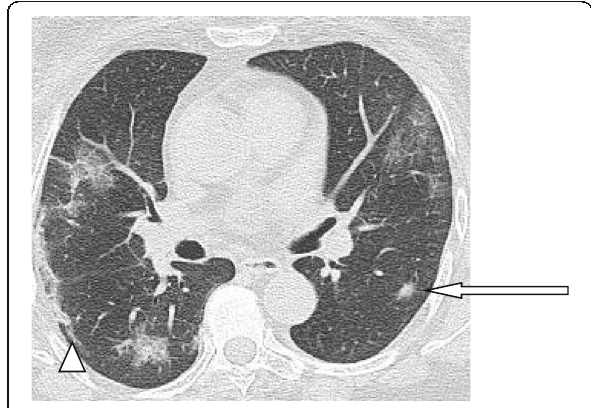
Fig. 11 Patient with COVID-19 pneumonia, with left lower nodule (arrow), note also the presence of ground glass patches and subpleural line (arrow